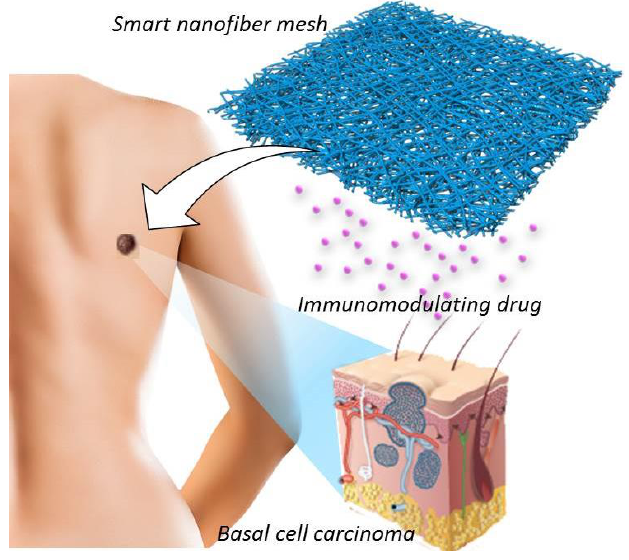
Figure 1. Schematic illustration for the nanofiber-based treatment of basal cell